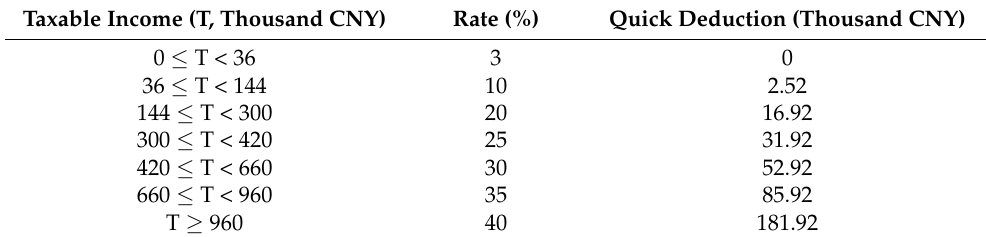
Data on environmental pollution taxes is available only as ranges for each province (Figure A1), with more population-dense provinces typically opting for higher tax rates across all pollutants. In each case, the average of the range for each province is used to calculate the applicable tax. Taxes are levied on plants’ sulphur dioxide, nitrous oxide, particulate matter, and wastewater emissions. The first three are levied at rates ranging from CNY 1.2–10/kg; wastewater is taxed at CNY 1.4–10.5/m 3 . Emissions of pollutants per MWh generated vary by plant type (see Table